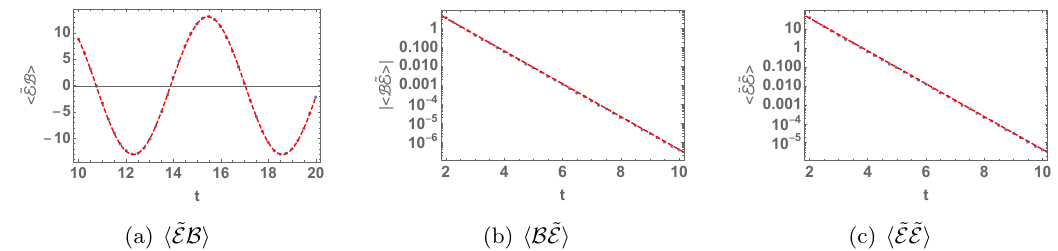
Figure 6 . Three contributions to the otoc in the case of the interpolating geometry. The blue dots correspond to the numerical solution while the dashed red lines correspond to the best (cid:12)t by functions of the form Ae (cid:0) 2 Bt for the decaying terms and A cos( Bt + C ) for the oscillating one. We set ~ (cid:12) = 2 (cid:25) and (cid:20)= ~ (cid:30) b = 1. A; B; C are constants to be (cid:12)tted. In all cases, the best (cid:12)t gives B (cid:25) 1.